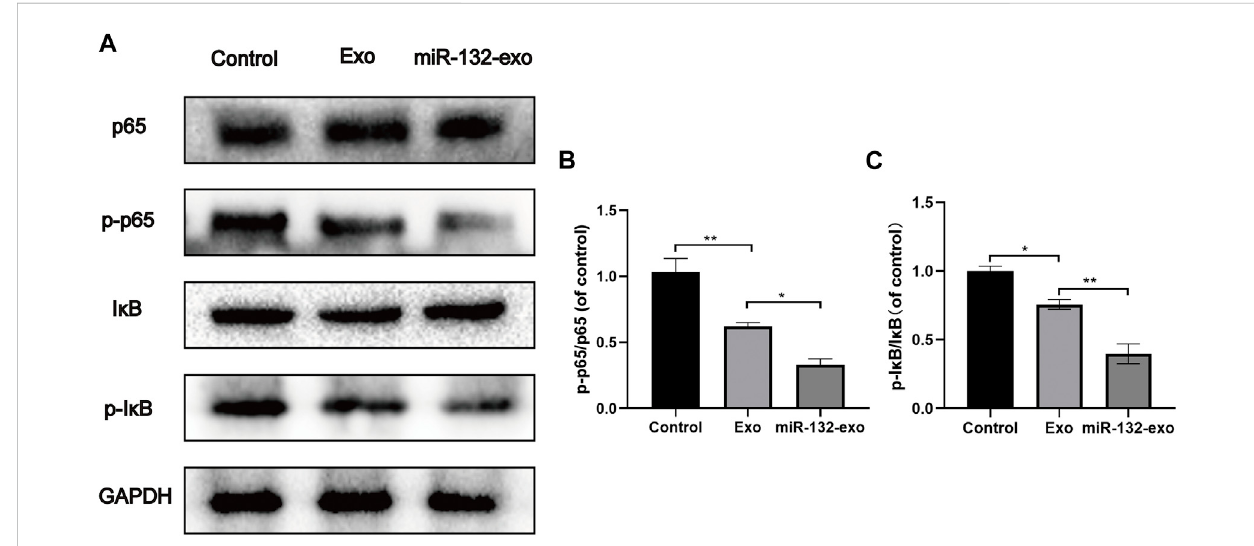
FIGURE 11 The miR-132-exo inhibited the NF-KB pathway in diabetic wounds. (A – C) Western blot bands and quantitative analysis of P65, PP65, l κ B, P-l κ B in each group. * p < 0.05, ** p < 0.01, *** p < 0.001, data are presented as the mean ± SD, n = 3.